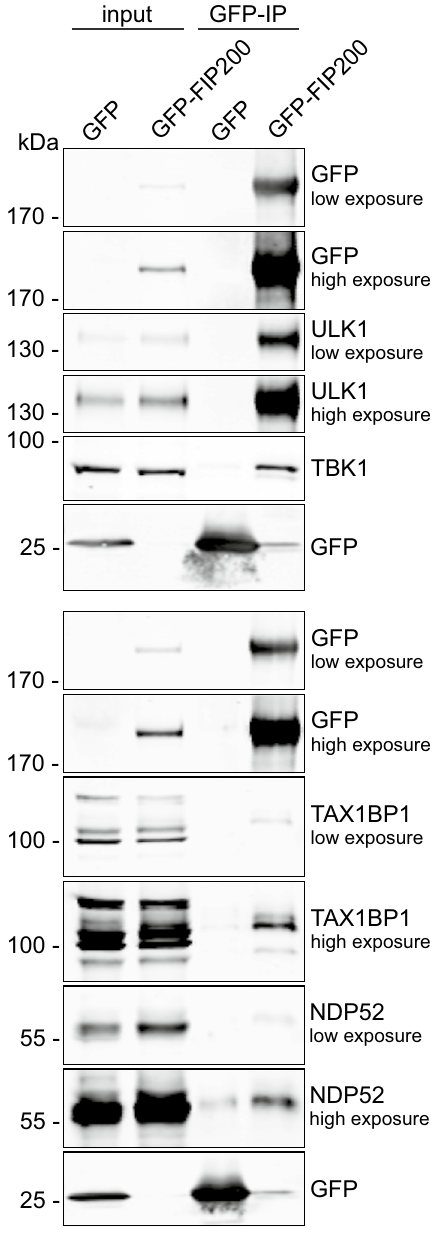
Figure 1. FIP200 interacts with TBK1. Flp-In T-REx 293 cells inducibly expressing GFP or GFP-FIP200 were treated with 0.1 µg/ml doxycycline for 16 h to induce expression. Afterwards, the GFP proteins were purified overnight using GFP-trap beads. Cleared cellular lysates (input) and purified proteins were immunoblotted for the indicated proteins. The full-length blots are presented in Figure